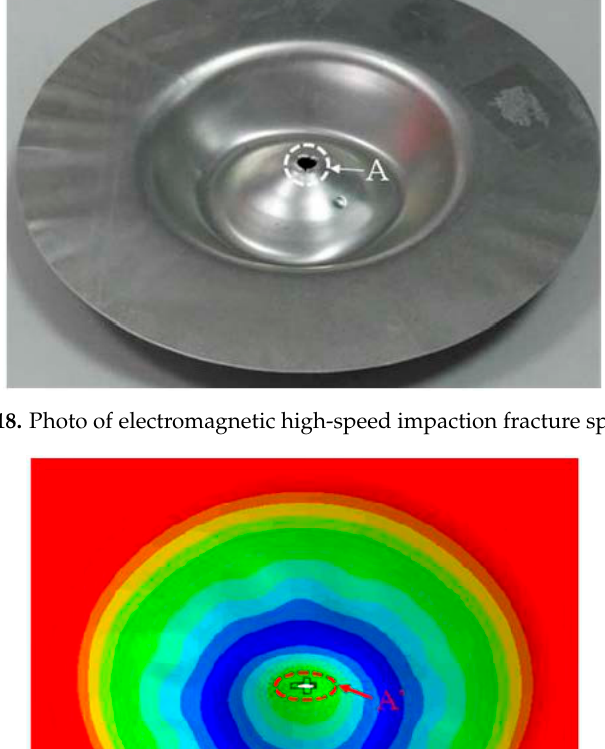
Figure 20. The fracture process of 5052-O aluminum alloy electromagnetic under impaction forming with the die at a discharge voltage of 13.5 kV, after: ( a ) 80 μ s; ( b ) 120 μ s; ( c ) 160 μ s; ( d ) 200 μ s; ( e ) 250 μ s; and ( f ) 300 μ s. During the high-speed impaction process, the void distribution of the sheet was heterogenous. The distribution of the void volume fraction was analyzed to predict the fracture location of the sheet. Figure 21 shows the void evolution in different positions. The three surface elements located